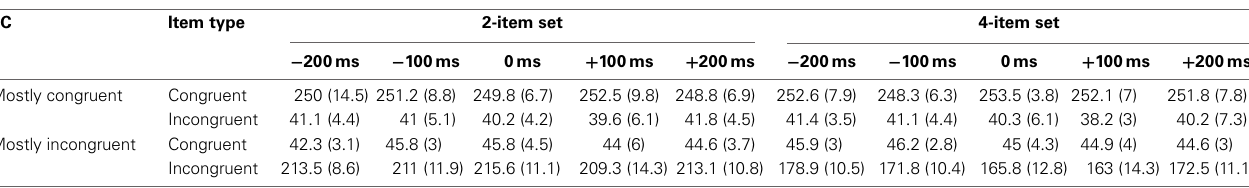
Table 7 | Average number of correct RTs per cell in Experiment